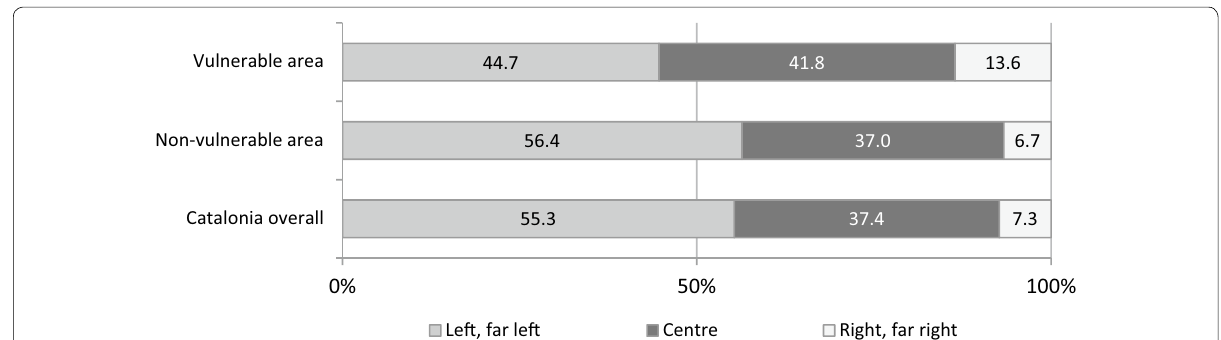
Fig. 2 Position on the left-right spectrum in Catalonia according to the level of urban segregation (2017) (Source: Own elaboration from the data provided by the Enquesta de Joventut de Catalunya,